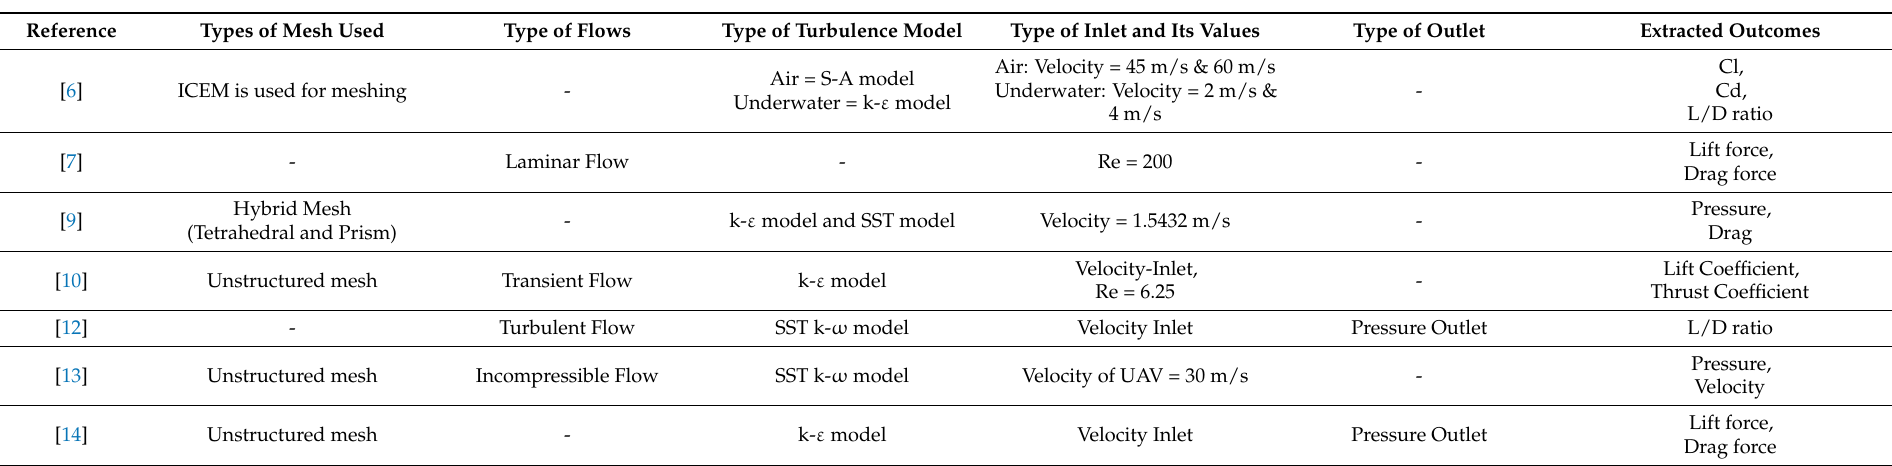
Table 2. Comparative information about parameters of CFD analysis on unmanned underwater